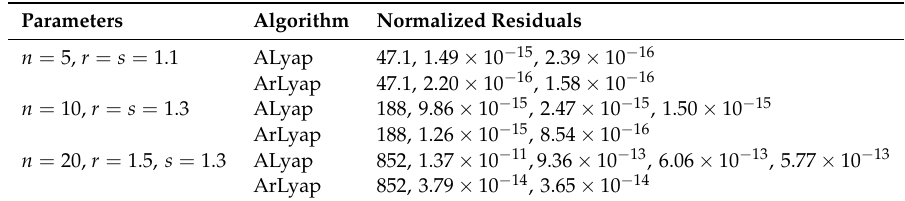
Table 1. Normalized residuals during iteration of ALyap and ArLyap solvers for three examples of the CTLEX 4.1 series.